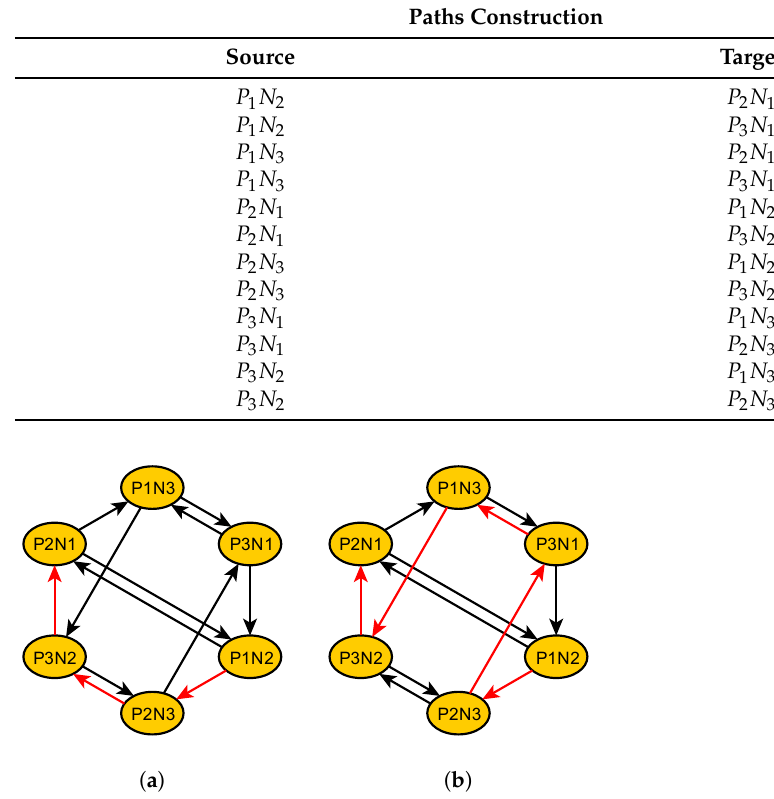
Table 3. Auxiliary table to track H graphs.